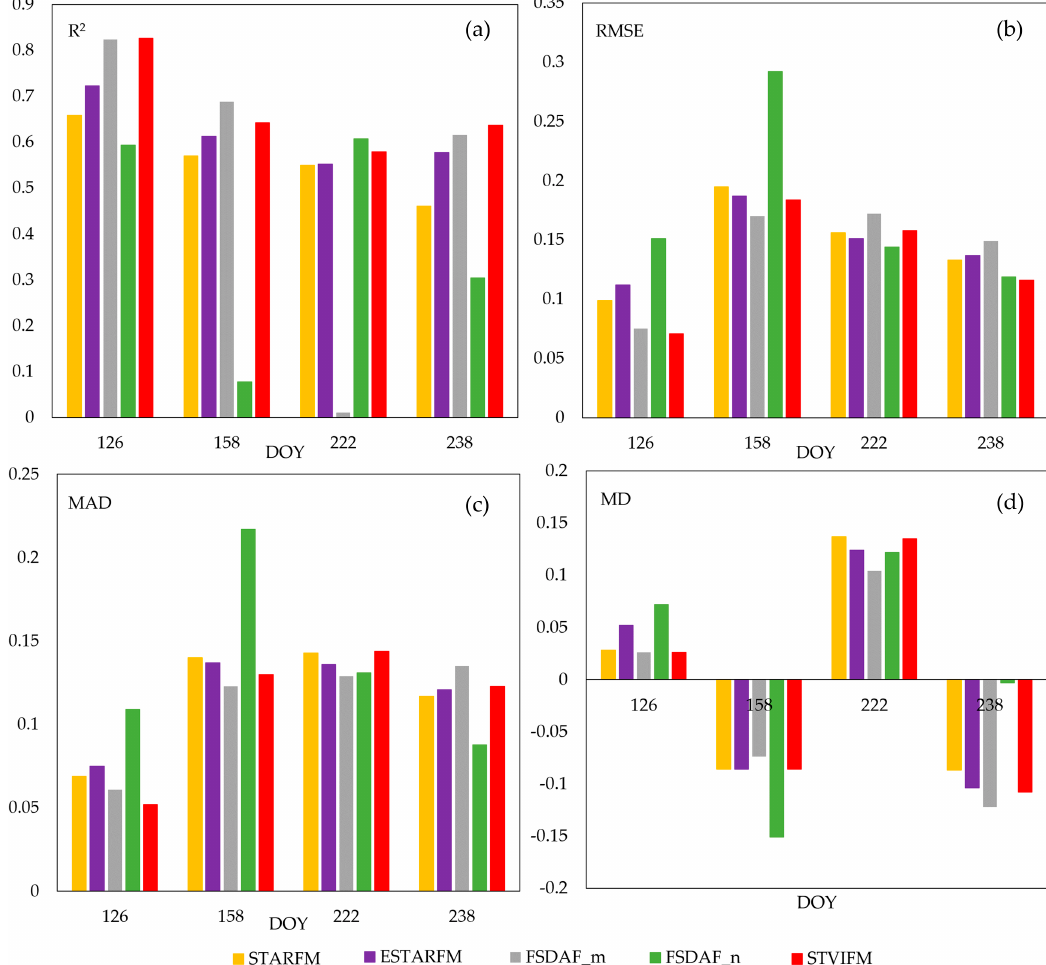
Figure 15. The accuracy of predicted NDVI obtained by different methods on four different dates in Ontario site during the growing season: ( a ) R 2 ; ( b ) RMSE; ( c ) MAD; and ( d ) MD.